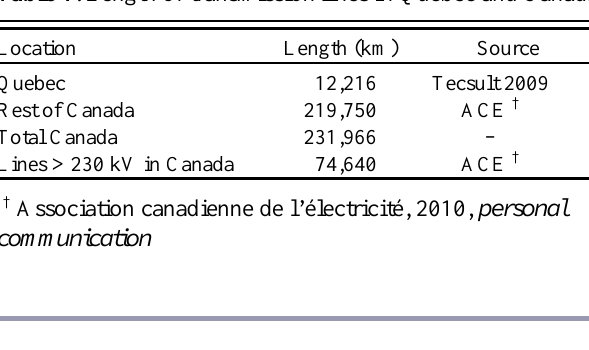
Fig. 1 . Distribution of high voltage transmission lines across Canada. Note that lower voltage transmission lines are not mapped consistently across Canada; therefore, we present only the 74,640 km of lines > 230 kV. Statistical